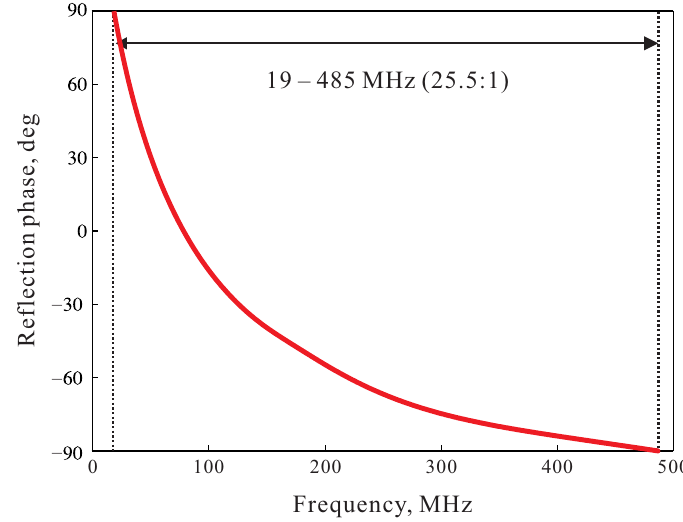
Figure 2. Simulated reflection phase for the unit cell of the designed AMC. Table 1. Comparison of the proposed AMC and AMC in previous studies (note that λ L is the wavelength of the lowest operating frequency).